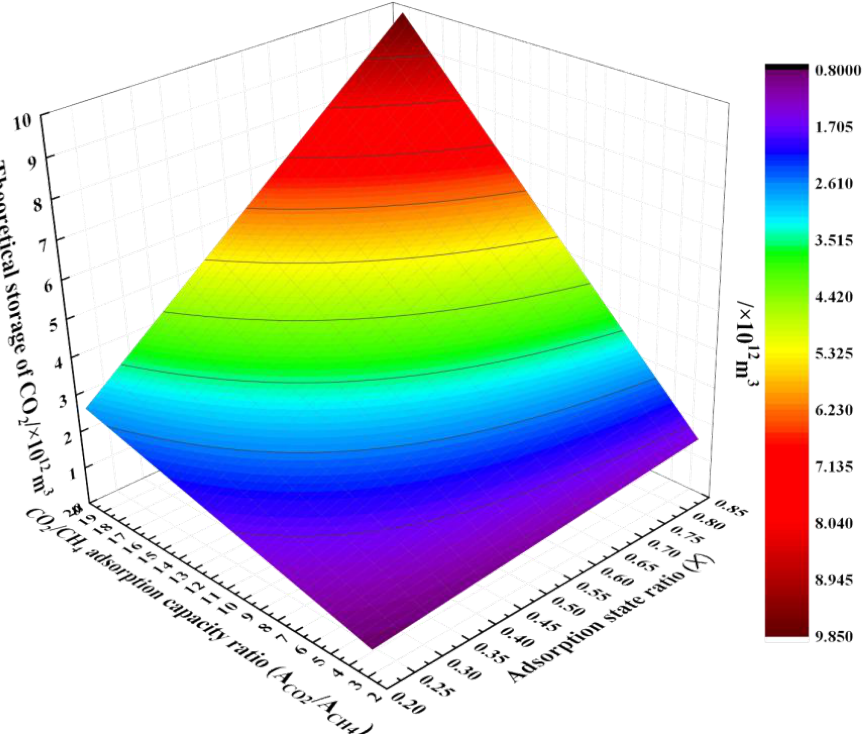
Figure 5. Theoretical storage of CO 2 in the Changning shale block.